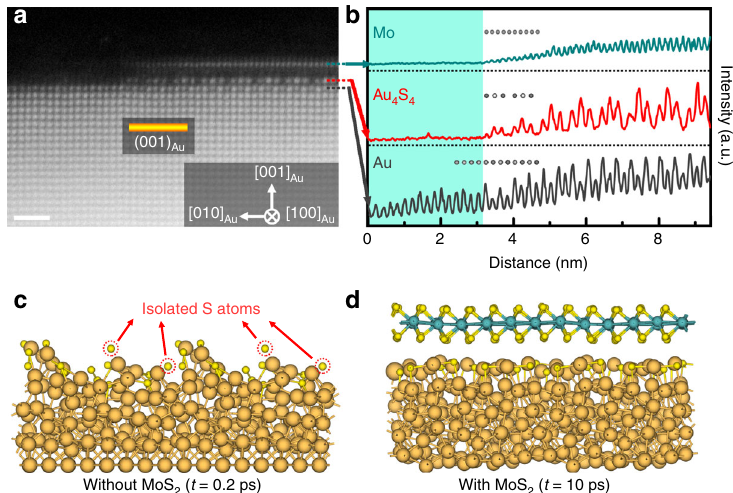
Fig. 8 The co-existence relationship between MoS 2 and reconstructed Au 4 S 4 structure. a HAADF-STEM image of a partially covered Au (001) surface by monolayer MoS 2 viewed from the [100] Au direction. Scale bar, 1 nm. b The corresponding intensity line pro fi le of Mo layer in MoS 2 (green line), Au 4 S 4 interface layer (red line) and Au sublayer (gray line). c , d Stability of the Au 4 S 4 phase in MD simulations without ( c ) or with ( d ) a monolayer MoS 2 top. The orange, green and yellow spheres represent Au, Mo, and S atoms,